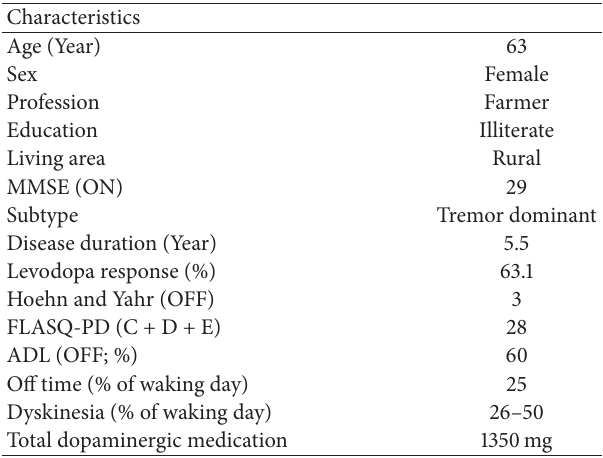
Table 1: Preoperative clinical and demographic characteristics of the